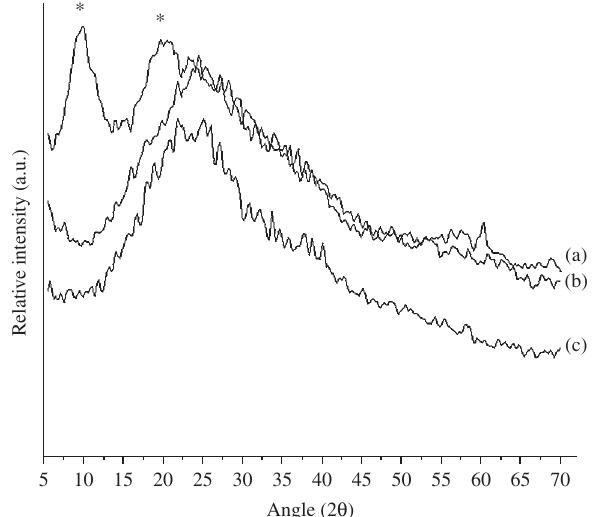
Figure 4. TG curves of samples: a) lyophilized PLGA 75:25; and b) lyophilized